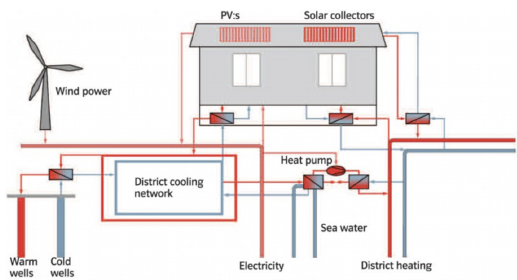
Figure 3. The Bo01 system: 100% locally renewable energy. Table 3. Renewable sources in Western